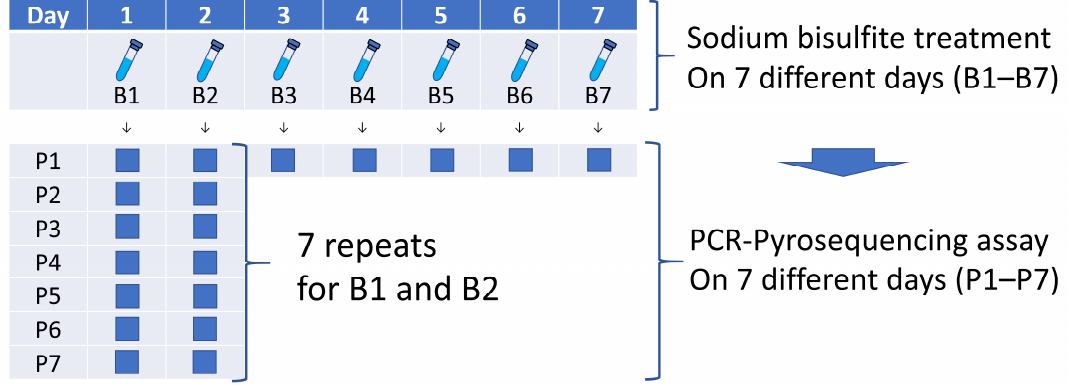
Figure 3. Validation procedure to assess precision of bisulfite conversion and PCR-pyrosequencing. Bisulfite conversion was performed on seven aliquots (B1 to B7) from each specimen. PCR-pyrosequencing was performed for seven bisulfite-treated specimens (B1 to B7) and was repeated seven times on two specimens (B1 and B2) on seven different days (P1 to P7). Abbreviation: PCR, polymerase chain